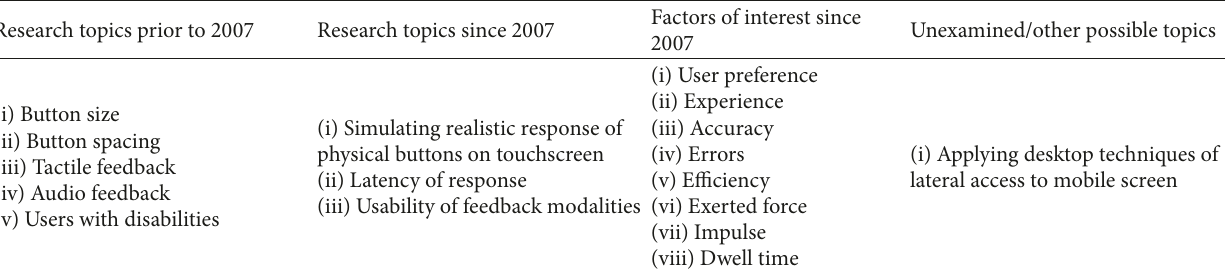
Table 10: Button